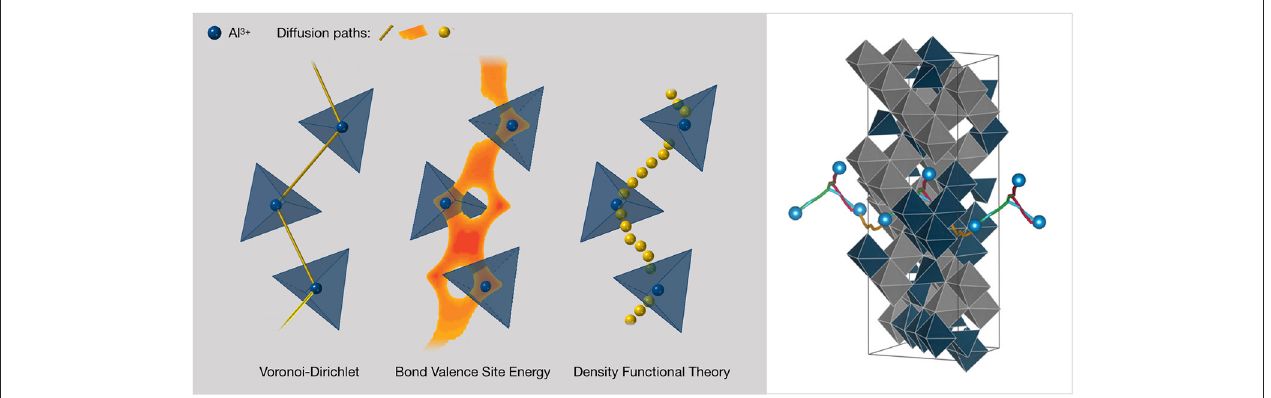
FIGURE 9 | Scheme of the suggested approach for identifying crystalline materials with fast ionic conduction for aluminum-ion battery materials: Voronoi-Dirichlet partitioning, bond-valence site-energies, density-functional theory (NEB) analysis. Simulation methods with different accuracy levels and thus computational effort, are performed in succession. Right: Al 3 + pathways investigated by DFT-NEB analysis in the 1 × 1 × 3 AlVO 3 supercell (Nestler et al., 2019b). All pathways are connected via a nearest-neighbor, unoccupied aluminum site. Blue octahedra represent AlO 6 , while gray octahedra are VO 6 . Blue balls represent the start and end positions in the investigated paths.